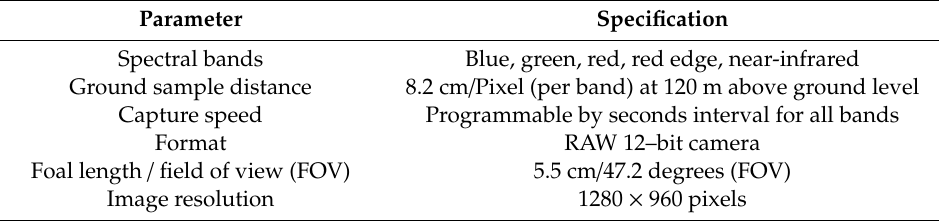
Figure 3. Equipment: ( a ) flight preparation and sensor calibration; and ( b ) ground control points (GCPs) collection. Table 1. Specifications of MicaSense RedEdge sensor.